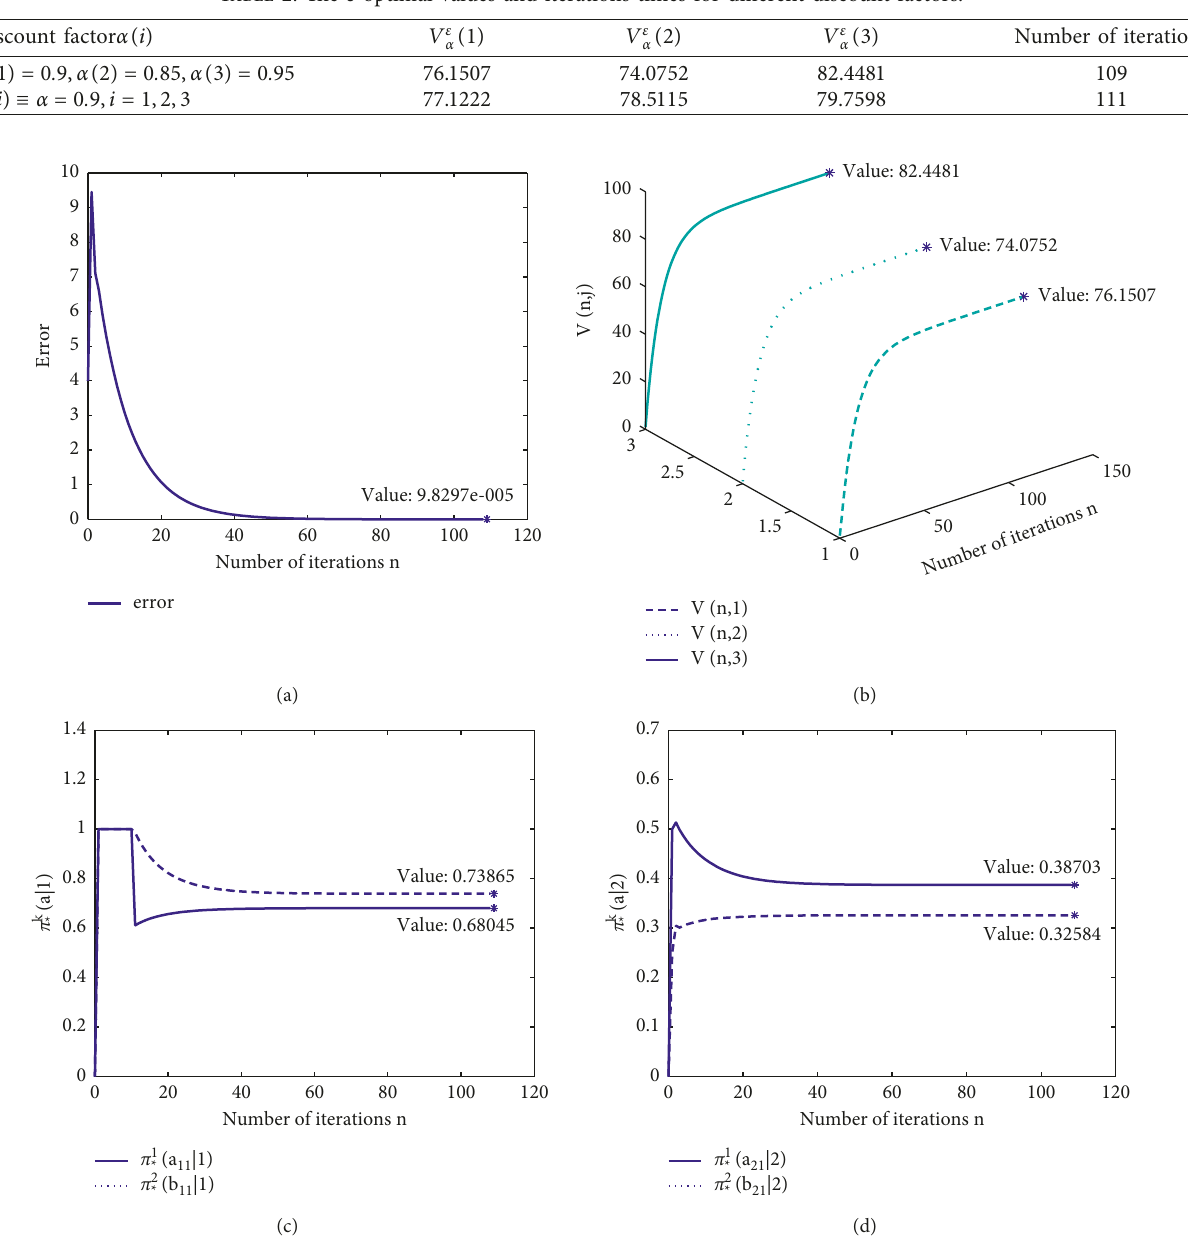
Table 2: The ε -optimal values and iterations times for different discount factors.